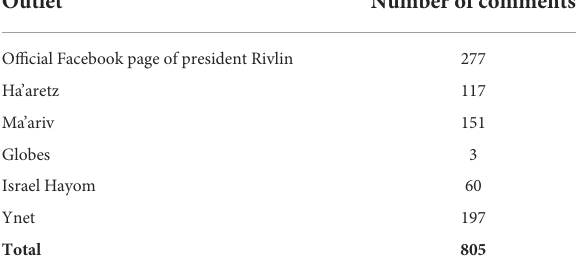
TABLE 1 Number of comments collected for each